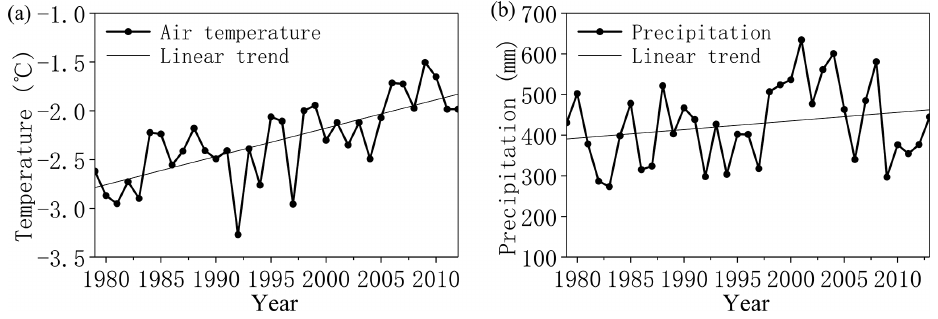
Figure 5. Variations in annual (a) mean air temperature and (b) precipitation from 1979 to